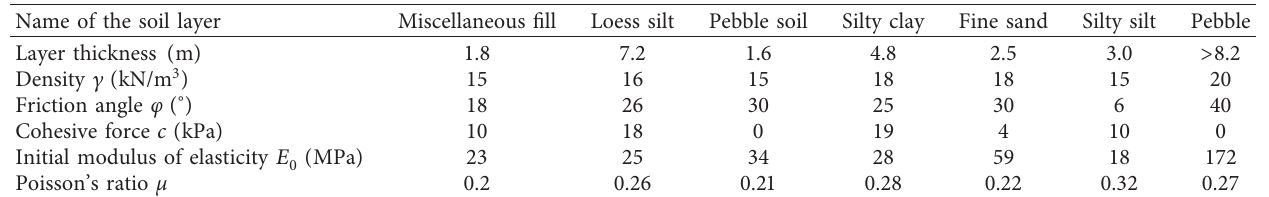
Figure 5: West side support section Table 1: Mechanical parameters of soil.